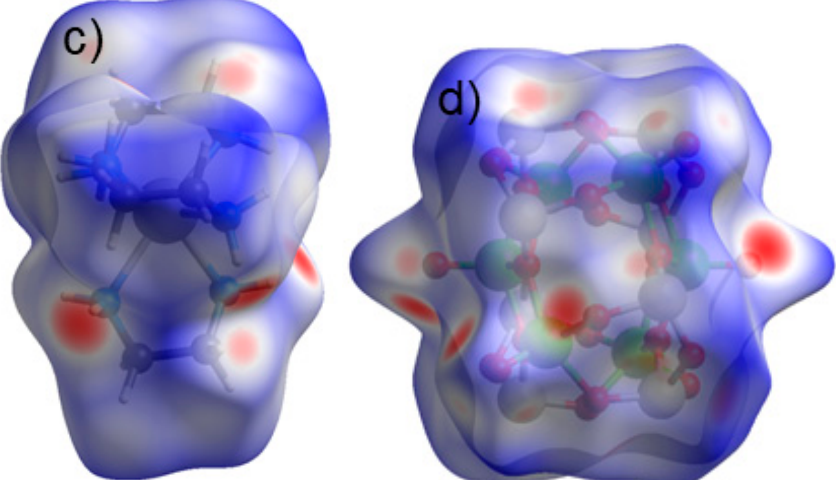
Figure 3. The Hirshfeld surfaces of the cation ( a ) and anion ( b ) of [M(en) 3 ] 2 [V 6 As 8 O 16 ] (M = Co, Zn); the Hirshfeld surfaces of the cation ( c ) and anion ( d ) of [Cd(en) 3 ] 2 [V 6 As 8 O 26 ]. Red areas on the Hirshfeld surface indicate intermolecular distances shorter than the sum of the van der Waals radii.